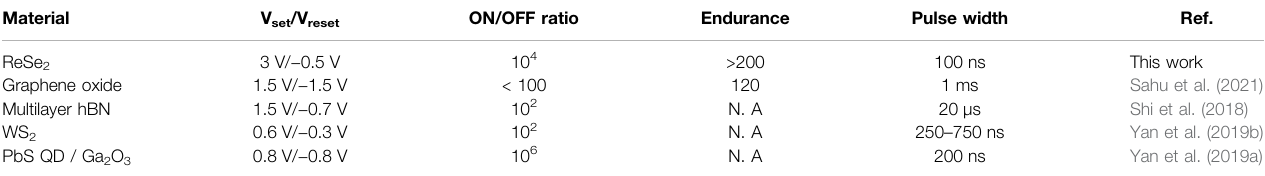
TABLE 1 | Comparison of the device characteristics of low-dimension material-based synapse devices. Material V set /V reset ON/OFF ratio Endurance Pulse width